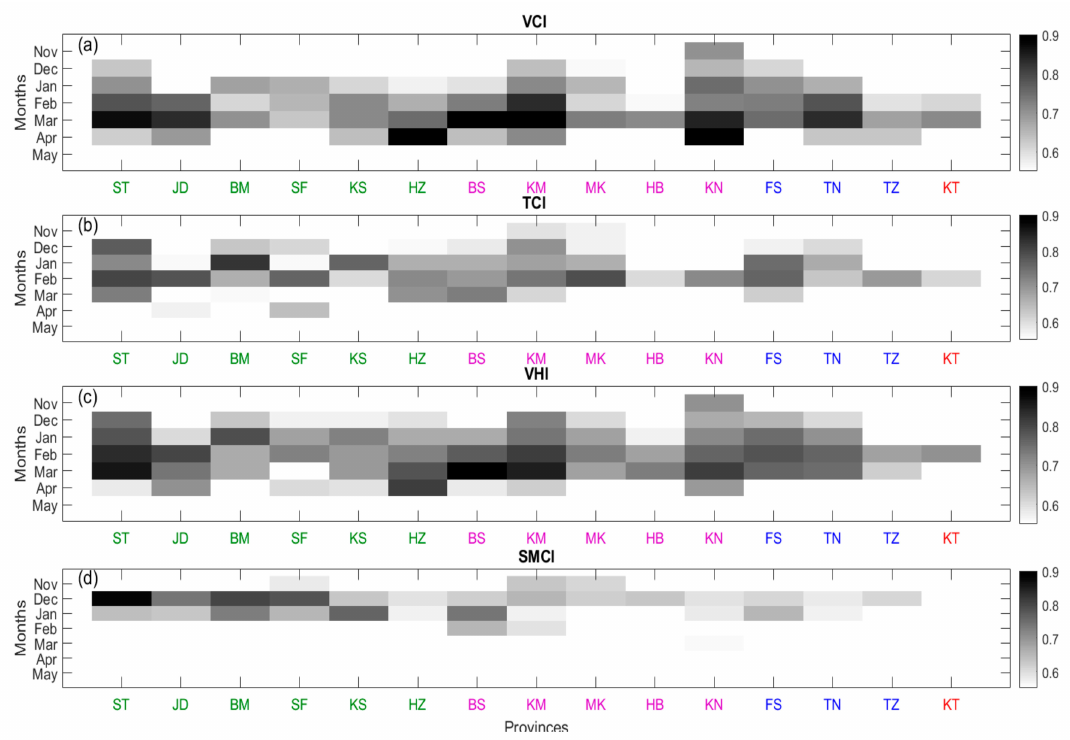
Figure 4. Correlations between the VCI ( a ), TCI ( b ), VHI ( c ), SMCI ( d ) and cereal yields on the province scale. ST: Settat, JD: El Jadida, BM: Beni Mellal, SF: Safi, KS: Kelaa des Sraghna, HZ: Haouz, BS: Ben Slimane, KM: Khemisset, MK: Meknes, HB: El Hajeb, KN: Khenifra, FS: Fes, TN: Taounat, TZ: Taza, KT: Kenitra. All the correlations are significant at the 99% level.